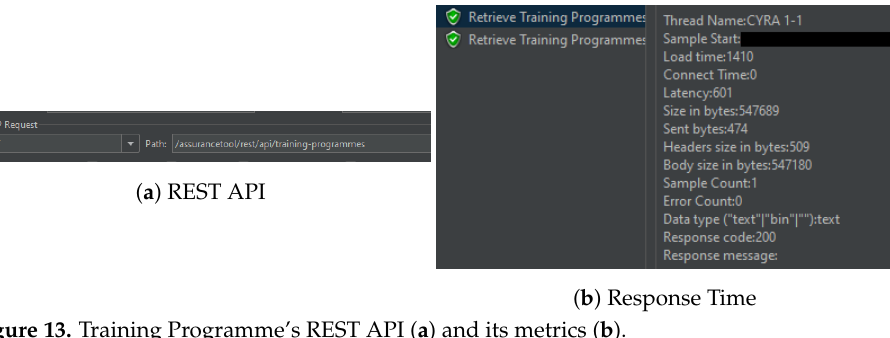
Figure 13. Training Programme’s REST API ( a ) and its metrics ( b ).